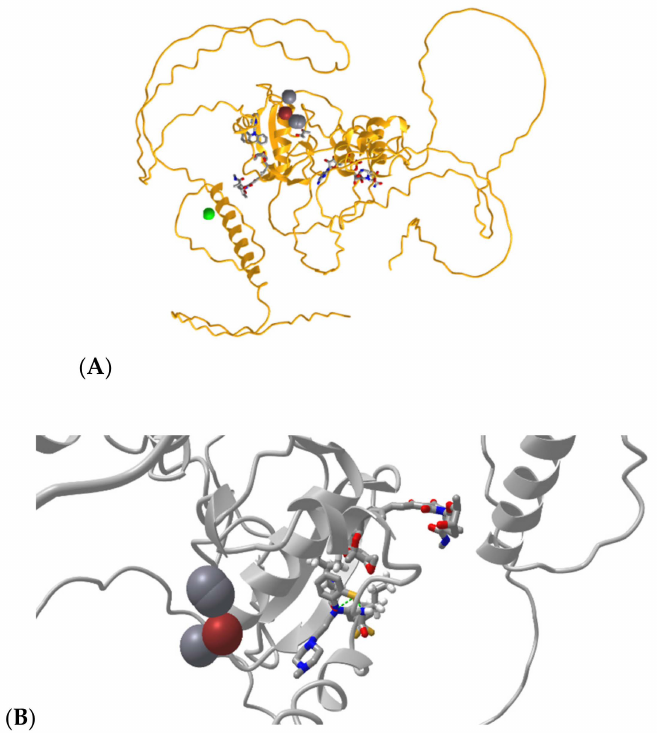
Figure 3. ( A ) Full-length BBM protein with ligand interactions at predicted active sites. ( B ) BBM- ligand interactions with focus on Zn (magenta ball), CLA (grey balls), STD, and